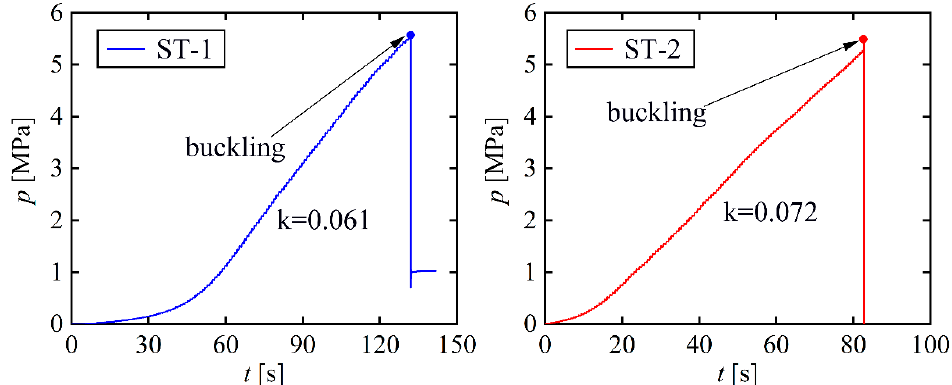
Figure 5. Pressure versus time curves for ST-1 and ST-2 sphere-segmented toroidal shells under uniform external pressure.